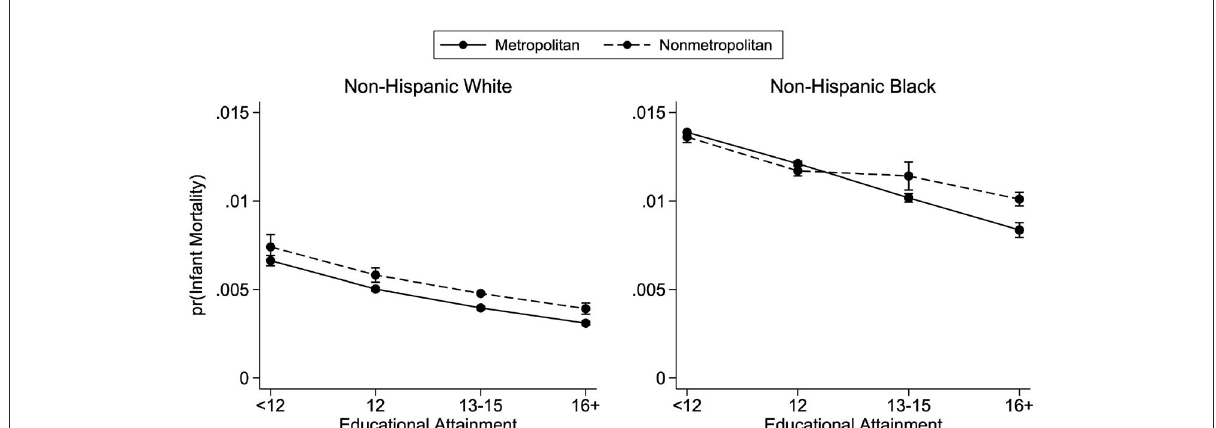
FIGURE5 Predicted probabilities of infant mortality by metropolitan residence and race—1998–2002. Predicted probabilities are from logistic regressions controlling for mother’s age, mother’s marital status, first trimester prenatal care, child’s sex, birth order, birth year, U.S. region of birth, and